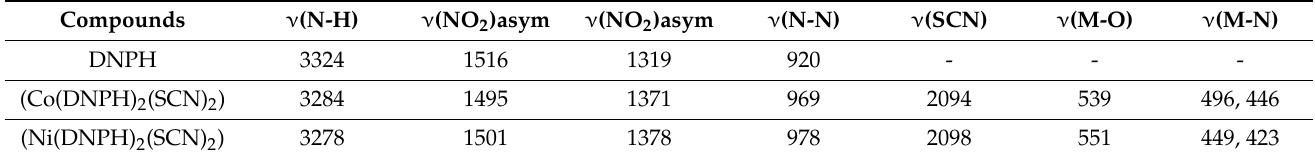
Table 2. Selected FTIR spectral data of the ligands and their metal complexes (cm − 1 ).